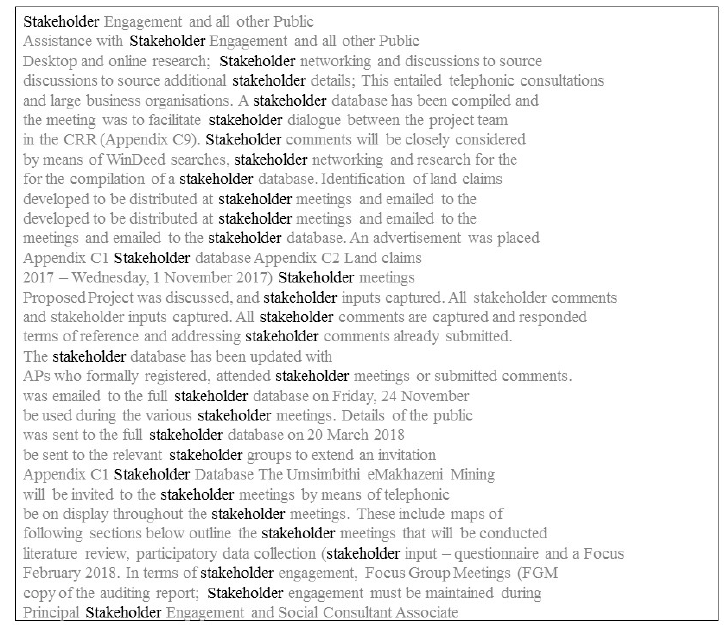
Figure A3: Collocation analysis, EIA Report.